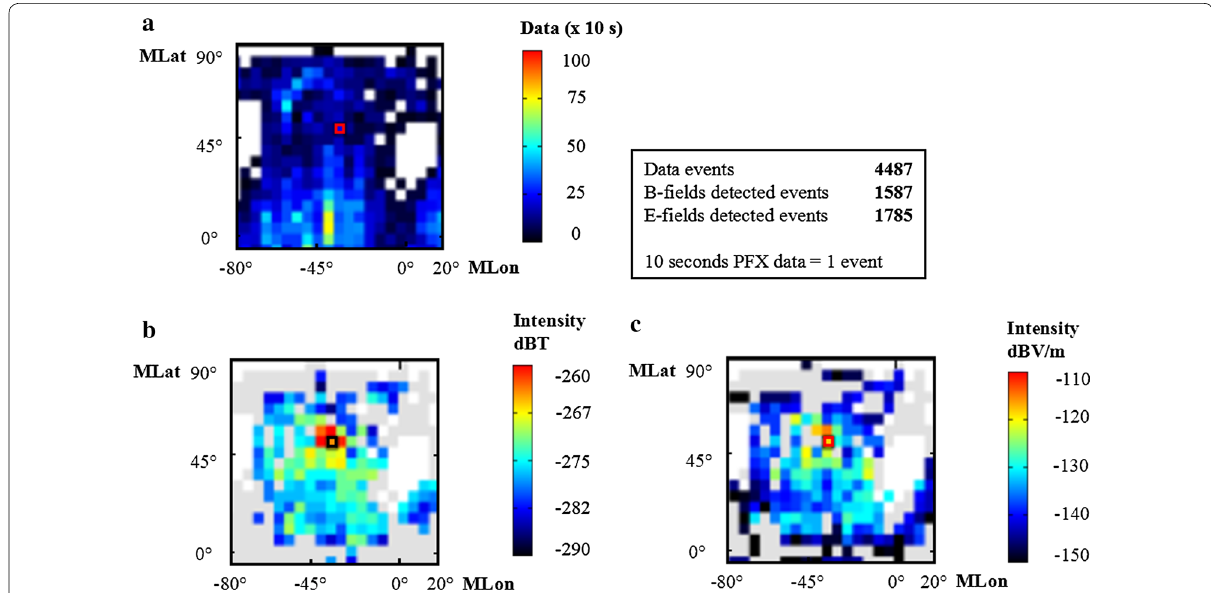
Fig. 4 a Duration of data processed in the magnetic and electric fields below altitude 640 km. b Omega signal propagation for the North Dakota station in the magnetic field and c in the electric field. The rectangle indicates the location of the North Dakota station at latitude 55.98° N and longitude 34.83°